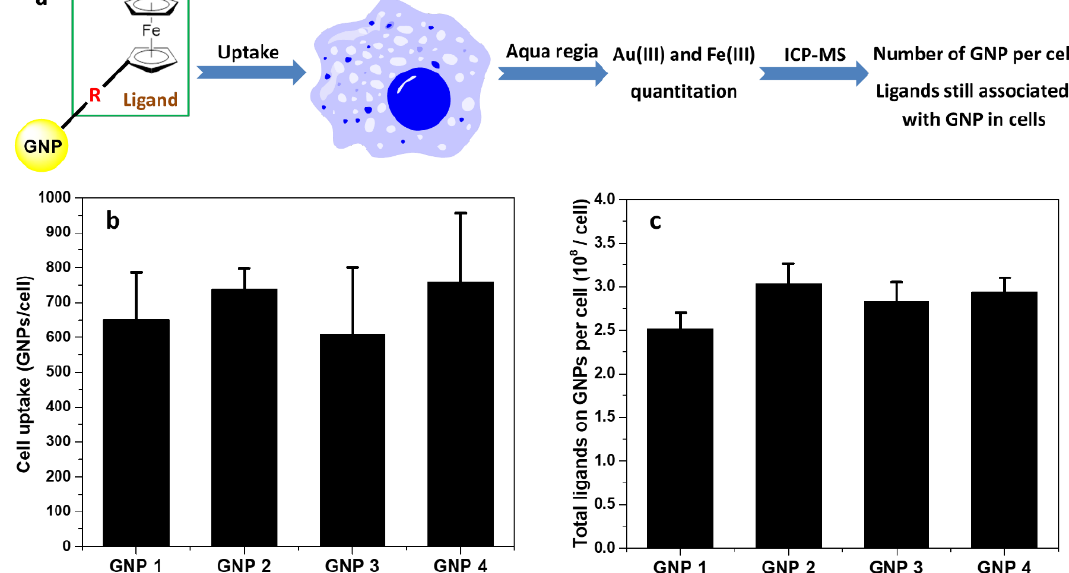
Figure 4. One-step determination of ligand loading on GNPs. The concentration of GNP was de- termined by the Au, and the concentration of ligand was determined by the Fe. Both determined using ICP-MS.